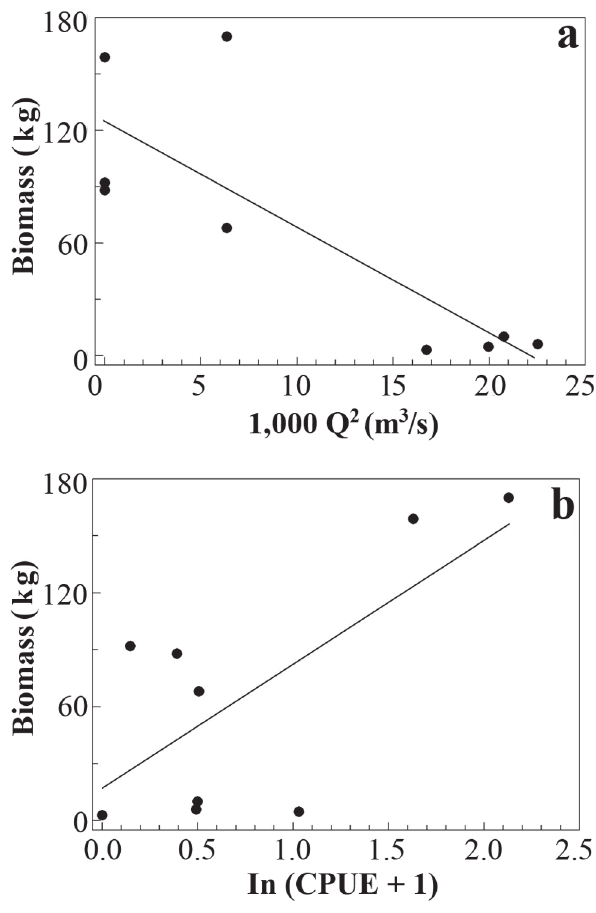
Fig. 6. The biomass of mandi trapped in the draft tube of Três Marias Dam during turbine dewatering versus turbine discharge ( a ) and the CPUE of mandi in the tailrace ( b